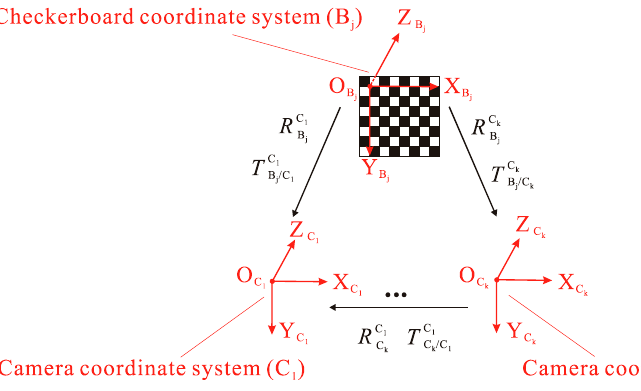
Figure 2. Multi-camera